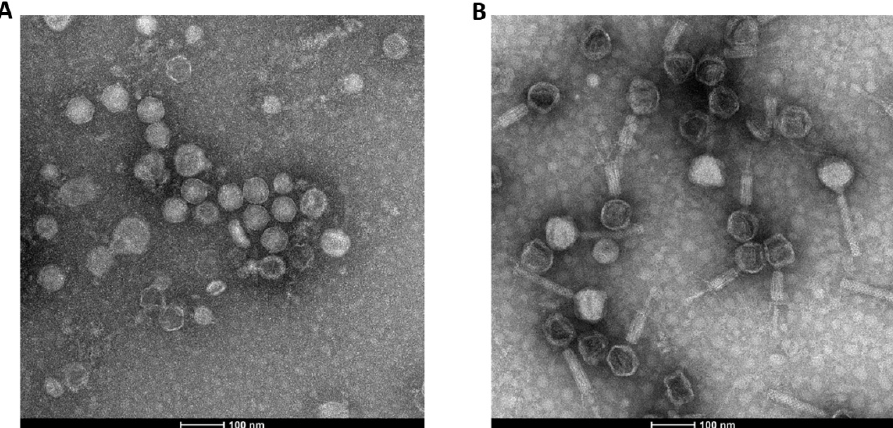
Figure 1. Transmission electron microscopy (TEM) pictures of LUZ19 ( A ) and 14 ‐ 1 ( B ) using a Tecnai Spirit microscope (FEI, Eindhoven, The Netherlands) operating at 120 kV, with a spot size of 1. Scale bar is 100nm.